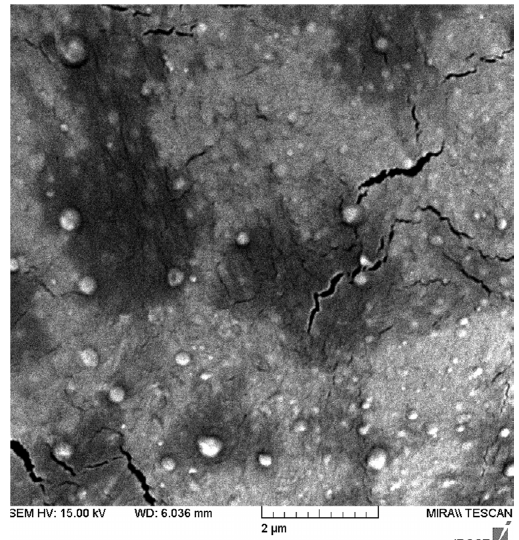
Fig. 3: SEM image of D-glucosamine nanoparticles carrying protein.